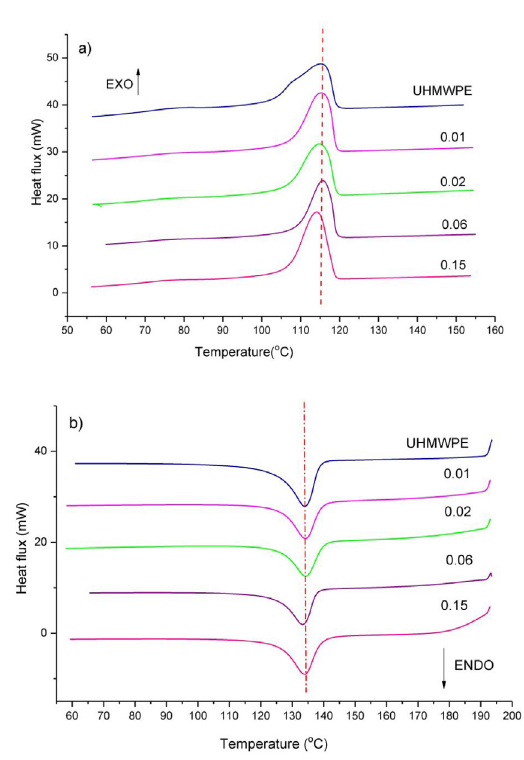
Figure 4. DSC curves for pure UHMWPE and its composites: a) Crystallization Temperature from melting; b) Melting Temperature upon second